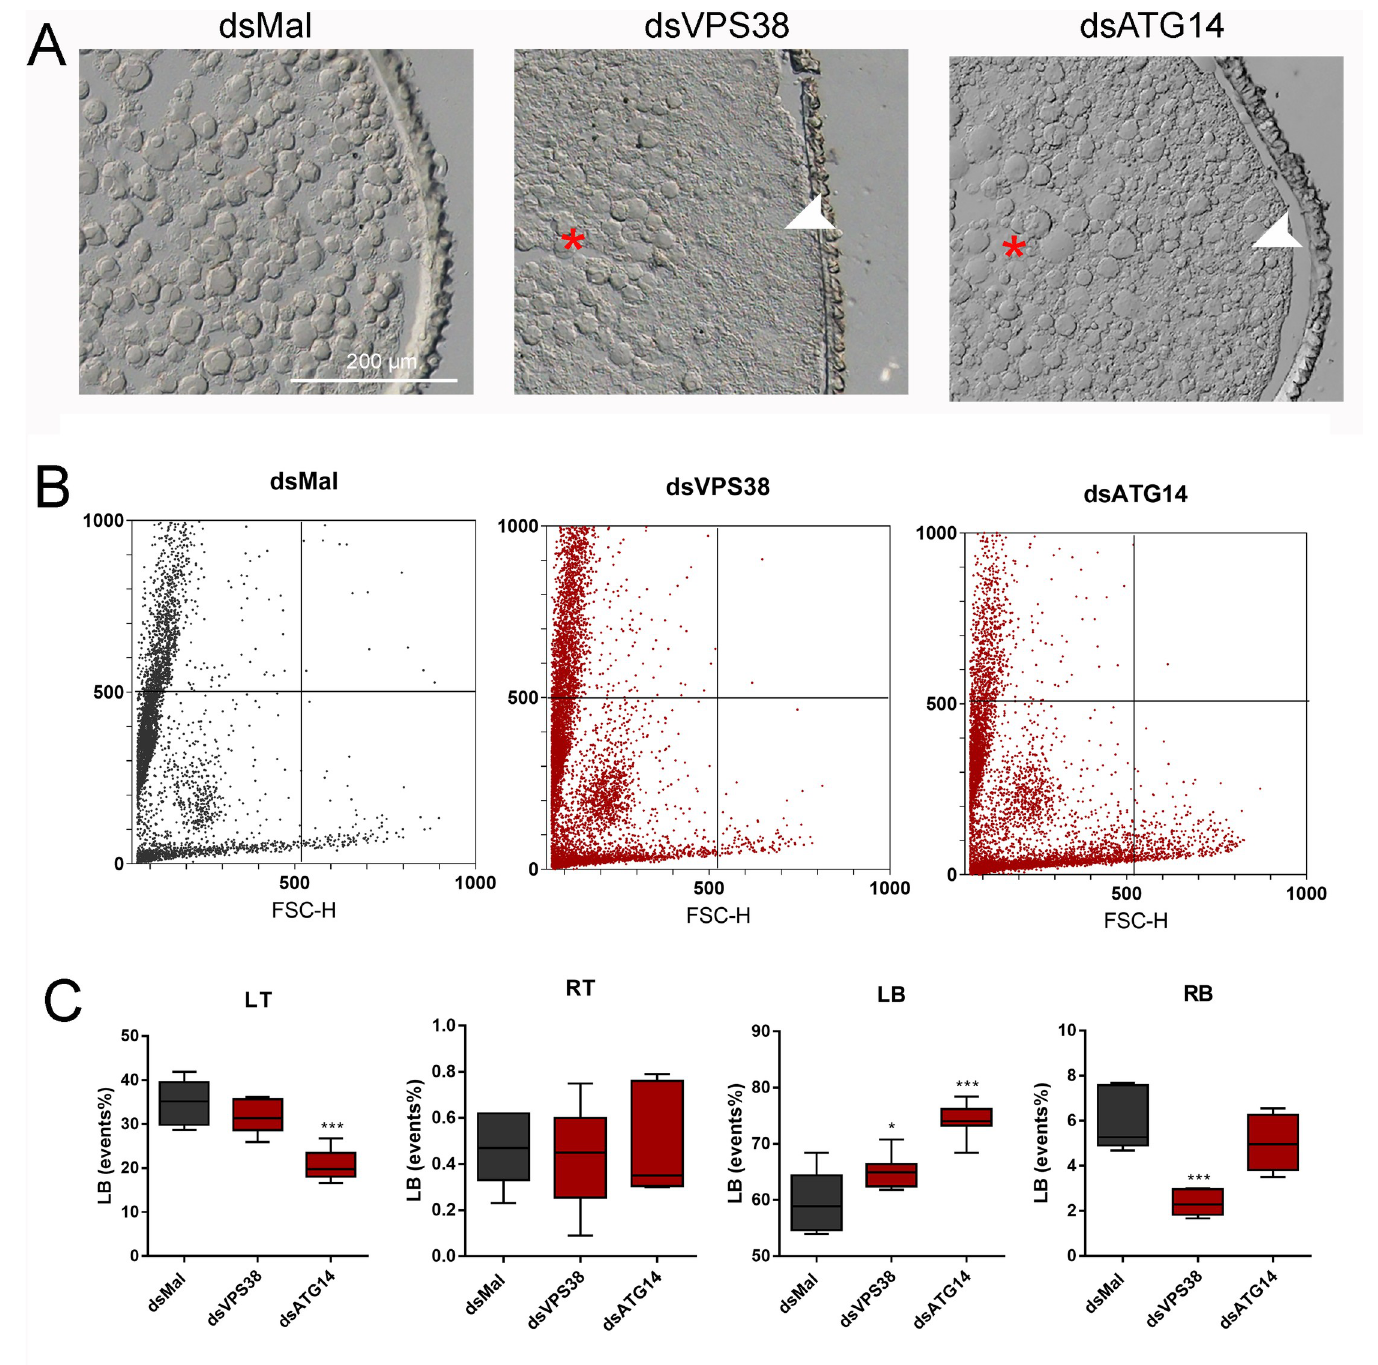
Fig 5. Knockdown of VPS38/UVRAG and ATG14 results in abnormal distribution of the yolk organelles. A. Representative images of cross-sections from chorionated oocytes were observed in the light microscope. The images show an accumulation of larger yolk organelles in the core cytoplasm (red asterisk) and an irregular distribution of smaller/abnormal organelles in the periphery of silenced oocytes (white arrowheads). Bars: 200 μ m. (n = 3). B. Flow cytometry FSC x SSC dot- plots of the yolk organelles extracted from chorionated oocytes obtained from control and silenced females. The plots are representative of five experiments (n = 5). C. Quantification of the organelles (events) frequency in each quadrant of the plots shown in B (RT, Right top; LT, left top; RB, right bottom; LB, left bottom). (n = 5) � p < 0.05, ��� p < 0.001, One Way ANOVA.